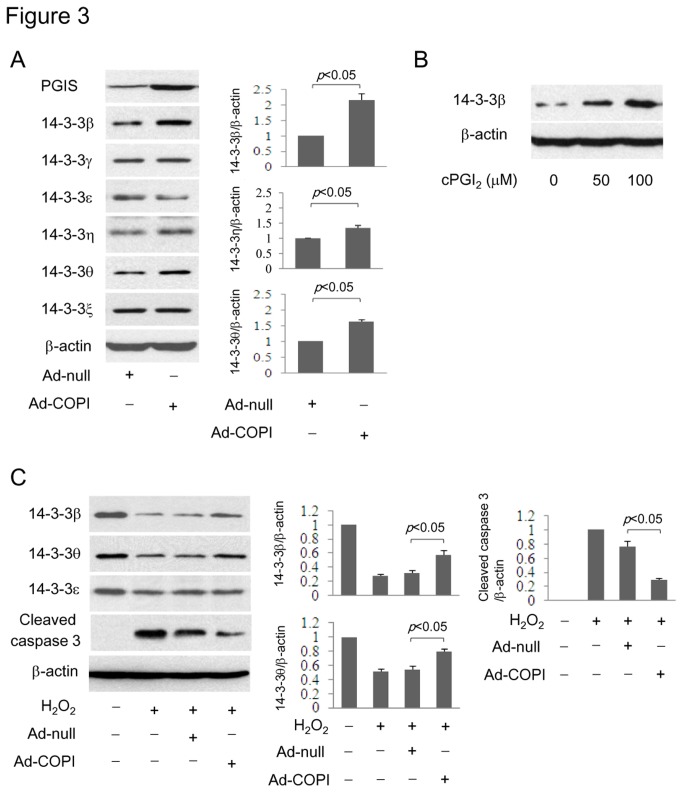
PGI2 increases 14-3-3β expression.(A) A-10 cells were transfected with Ad-COPI or control adenoviral vector Ad-null. 14-3-3 proteins were determined by Western blotting. Left panel shows representative Western blots and right panel shows densitometry analysis. (B) Cells were treated with cPGI2. 14-3-3β was measured by Western blotting. (C) Ad-COPI or Ad-null transfected cells were treated with H2O2. 14-3-3 isoforms and cleaved caspase 3 were analyzed. Left panel shows representative Western blots and right panel shows densitometry analysis. Each error bar denotes mean±SEM and all blots are representative of n≥3.